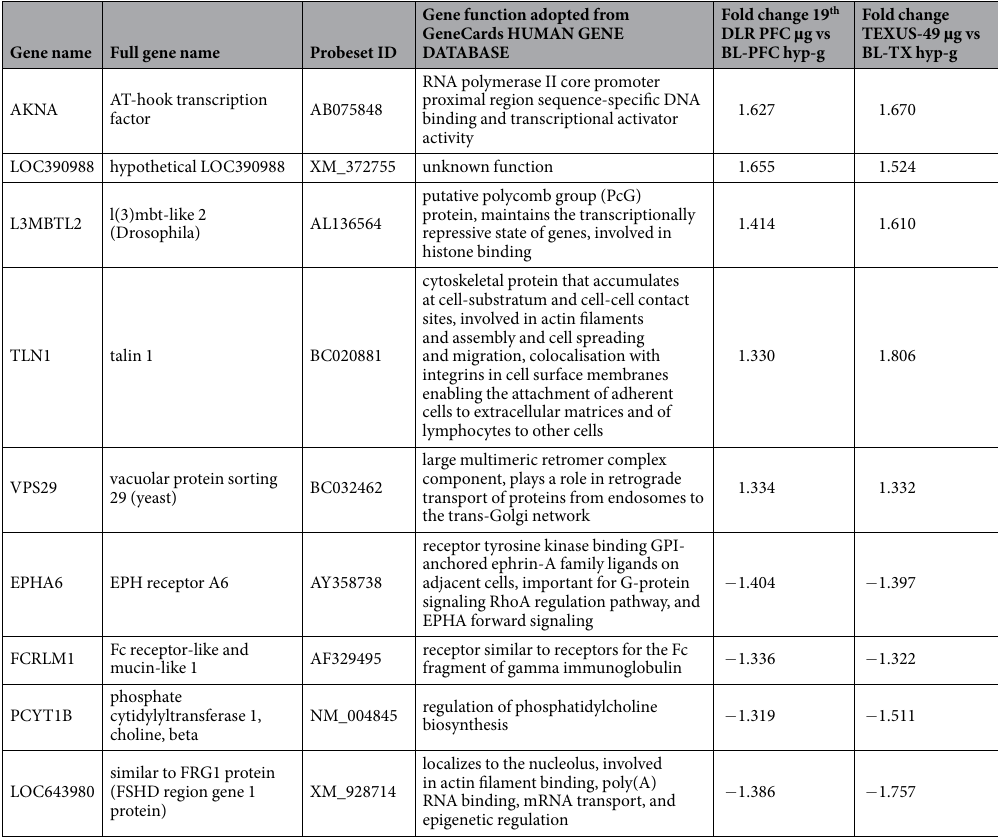
Table 9. Differentially regulated annotated transcripts in microgravity identified in the 19 th DLR parabolic flight and TEXUS-49 suborbital ballistic rocket campaigns. Annotated transcripts with continuous response for up or down-regulation after 20 s and 300 s of microgravity are shown. Positive sign: significantly up-regulated transcripts (p-value < 0.05, FC ≥+ 1.3), negative sign: significantly down-regulated transcripts (p-value < 0.05, FC ≤− 1.3). FCs are ratios between the averages of linear expression values. If the ratio is < 1, FC is calculated as the negative reciprocal of the